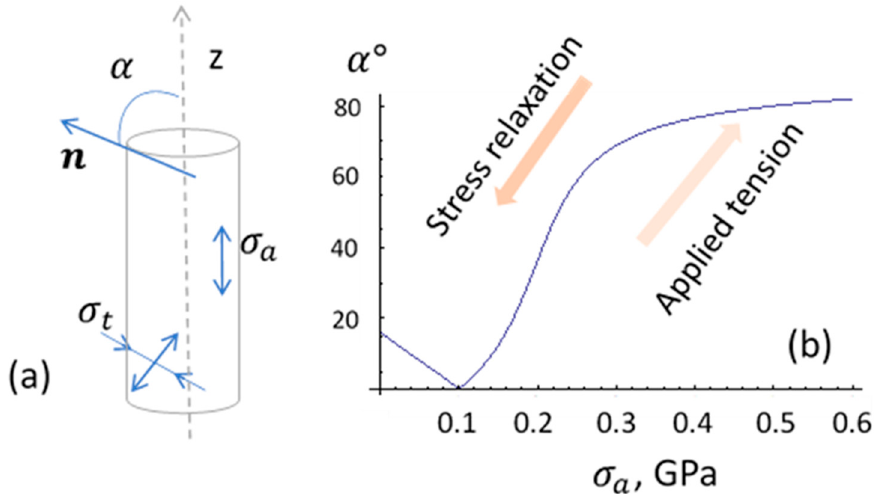
Figure 2. In ( a ), schematic representation of various stress contributions to the easy anisotropy of amorphous wire; in ( b ), dependence of the angle α between the easy axis n and the wire axis z on tensile amorphous wire; in ( b ), dependence of the angle 𝛼 between the easy axis 𝒏 and the wire axis z on stress σ a . Parameters used for calculation: λ s 0 = 2.5 × 10 − 8 , β = 0.9 × 10 − 10 MPa tensile stress 𝜎 (cid:3028) . Parameters used for calculation: 𝜆 (cid:3046)(cid:2868) = 2.5 × 10 (cid:2879)(cid:2876) , 𝛽 = 0.9 × 10 (cid:2879)(cid:2869)(cid:2868) MPa (cid:2879)(cid:2869) , and (cid:2870)(cid:3012) In order to describe a smooth transformation in the easy angle α , a small torsion stress σ t = 40 MPa 160 A/m . In order to describe a smooth transformation in the easy angle 𝛼 , a small torsion stress was 𝜎 (cid:3047) = 40 MPa was introduced.